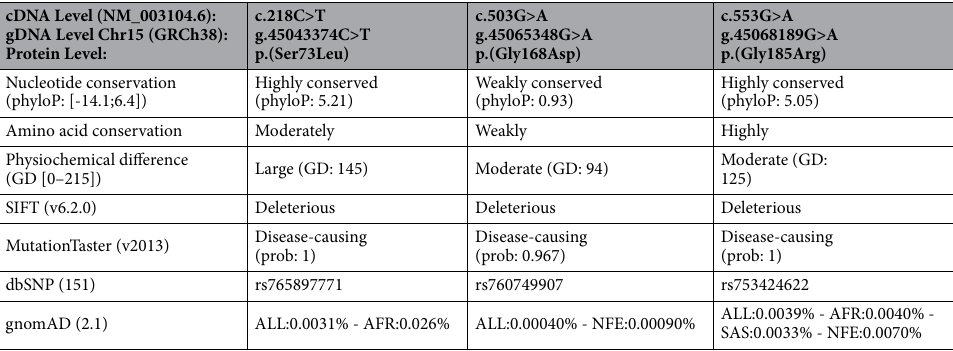
Table 1. The characterization of novel SORD variants detected in this study (Alamut Visual version 2.15 (SOPHiA GENETICS, Lausanne, Switzerland)). GD Grantham distance; prob probability.